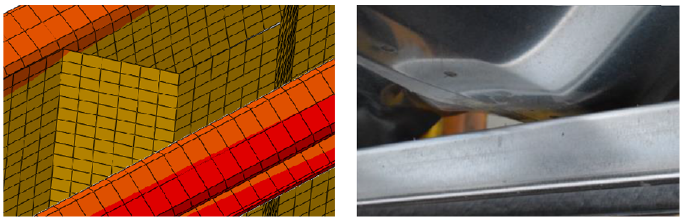
Figure 14. Failure of a spot weld connecting the corrugated web and the flanges.